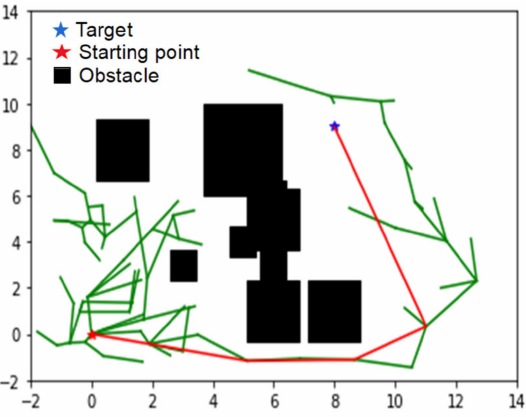
Figure 6. Diagram of the I-RRT algorithm implementation to remove redundant nodes.